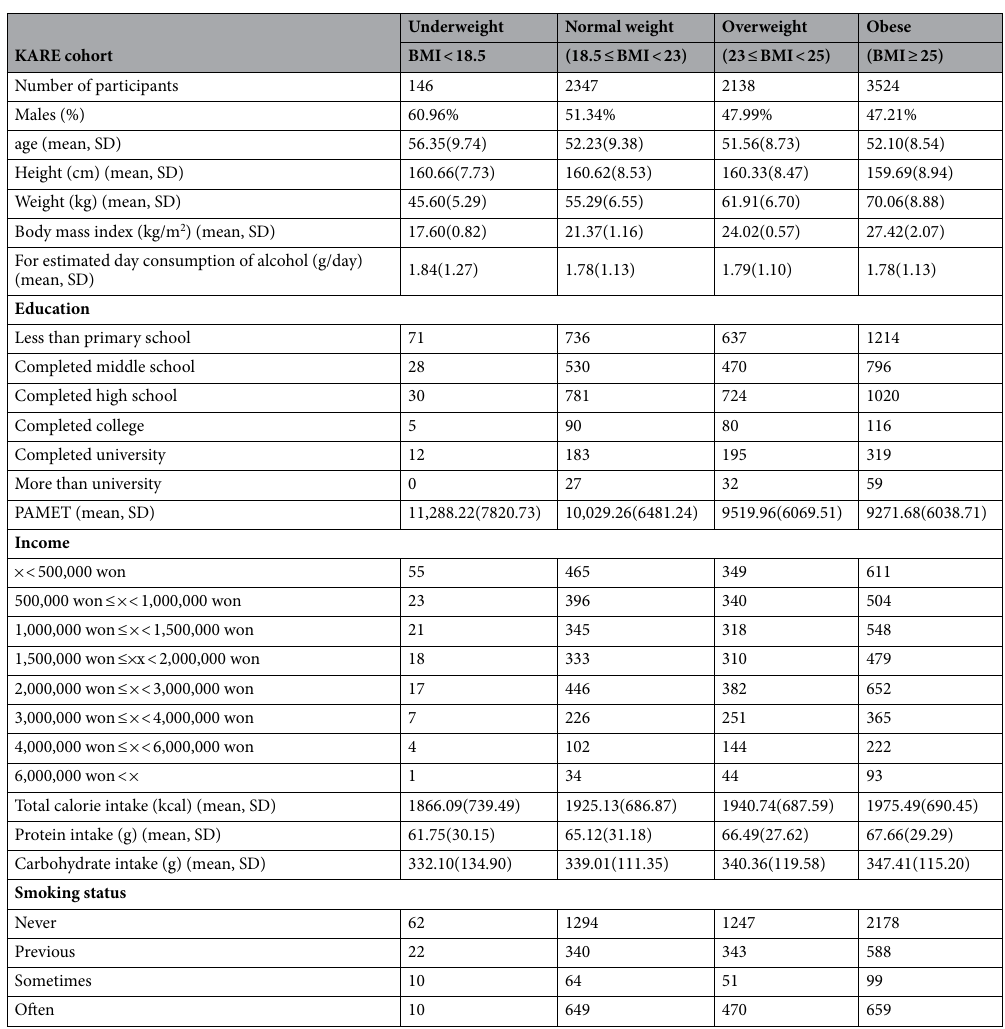
Table 1. Basic characteristics of Korean Association Resource (KARE) participants included in this study, stratified by weight as a criterion. The numbers with percentile indicate mean and standard deviation (SD), and the numbers without percentile indicate the sample number in the